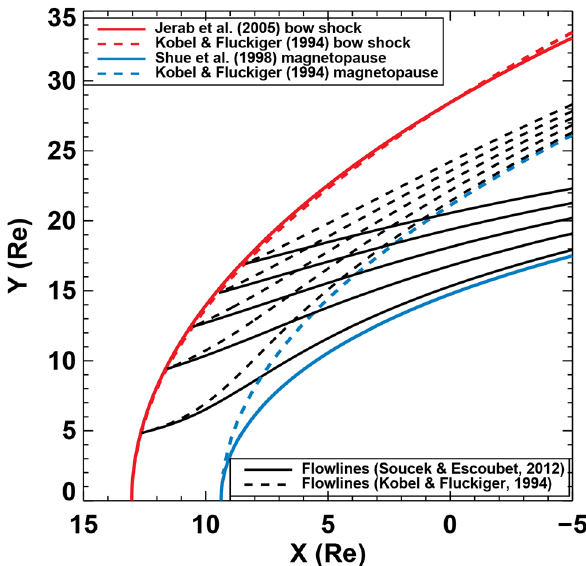
Fig. 1. Boundaries: Jeˇráb et al. (2005) bow shock model (solid red line), Kobel and Flückiger (1994) bow shock model (dashed red line), Shue et al. (1998) magnetopause model (solid blue line), Kobel and Flückiger (1994) magnetopause model (dashed blue line) – Flowlines in the magnetosheath: in the Soucek and Escoubet (2012) model (solid black lines) and in the Kobel and Flückiger (1994) model (dashed black